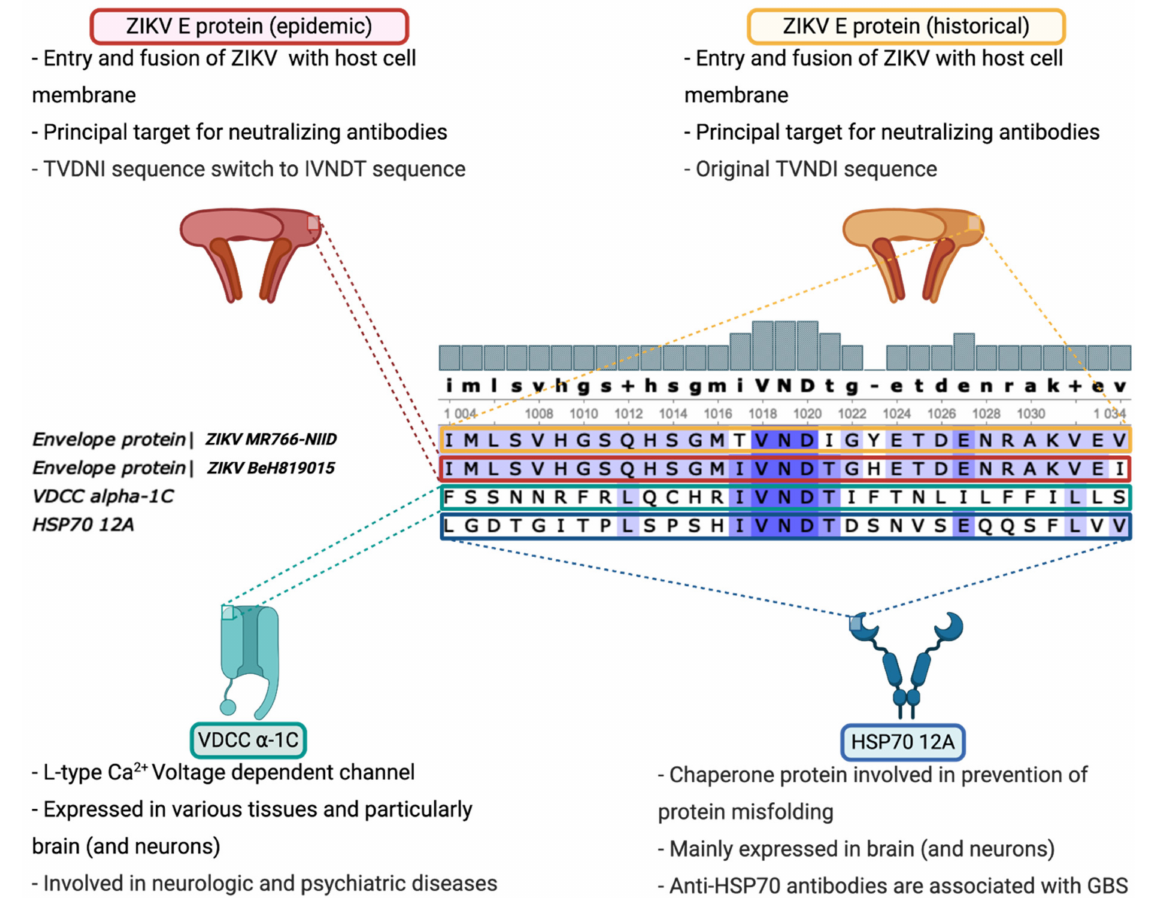
Figure 1. Calcium channel voltage-dependent L type α -1C subunit and Heat Shock 70 kDa protein 12A are potential candidates for molecular mimicry following ZIKV infection. Comparative analysis of Brazilian strain of ZIKV (BeH819015) and laboratory-adapted historical strain of ZIKV (MR766-NIID) revealed that an IVNDT polypeptide, only found in epidemic strain, might be related to ZIKV-related GBS due to calcium channel voltage-dependent L type α -1C subunit or Heat Shock 70 kDa protein 12A molecular